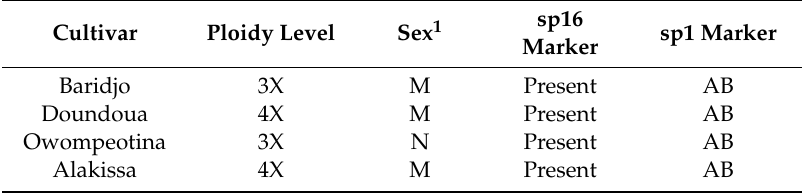
sp16 sp1 Marker Marker